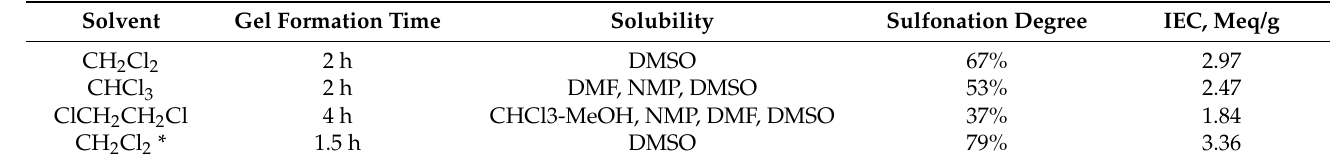
Table 2. Sulfonation of HPPhNB.